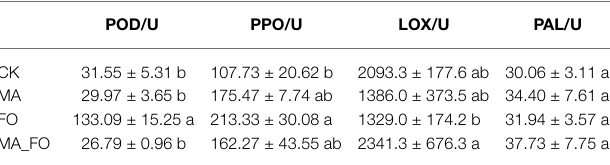
TABLE 1 | Plant defense enzyme activities of ginseng root treated by differential inoculation.